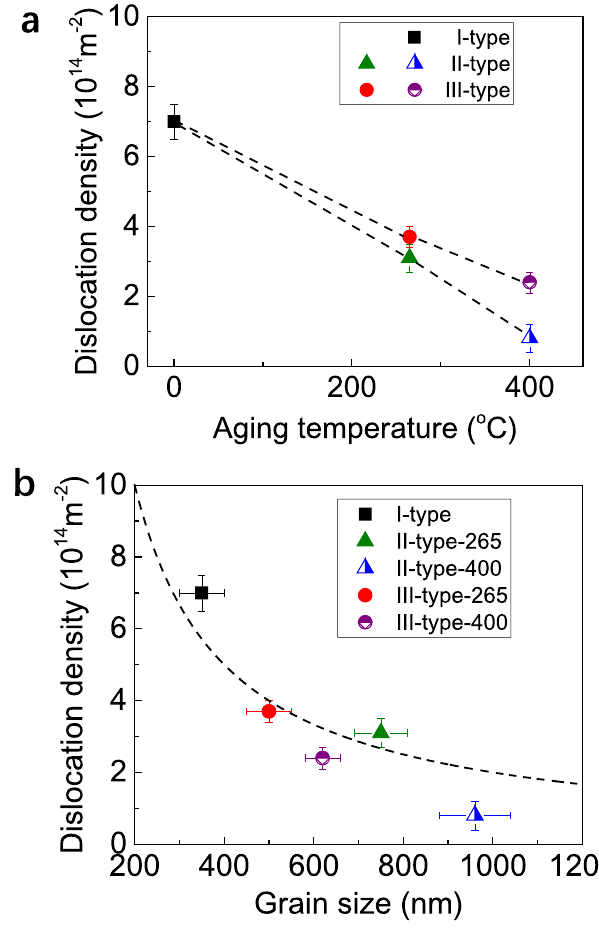
Figure 2. Experimental measurements on the dislocation density and dislocation density-grain size correlation. ( a ) Dislocation density of the Al-Zr conductors under different processing routes (I-type with no aging, II-type with post-aging after cold drawing, and III-type with pre-aging before cold drawing) and different aging temperature (265 and 400 °C). The aging temperature of 0 corresponds to I-type with no aging. ( b ) Correlation between the dislocation density ( ρ ) and the average grain size ( d ). The dash line follows the expression of d ∝ ( ρ ) − 1